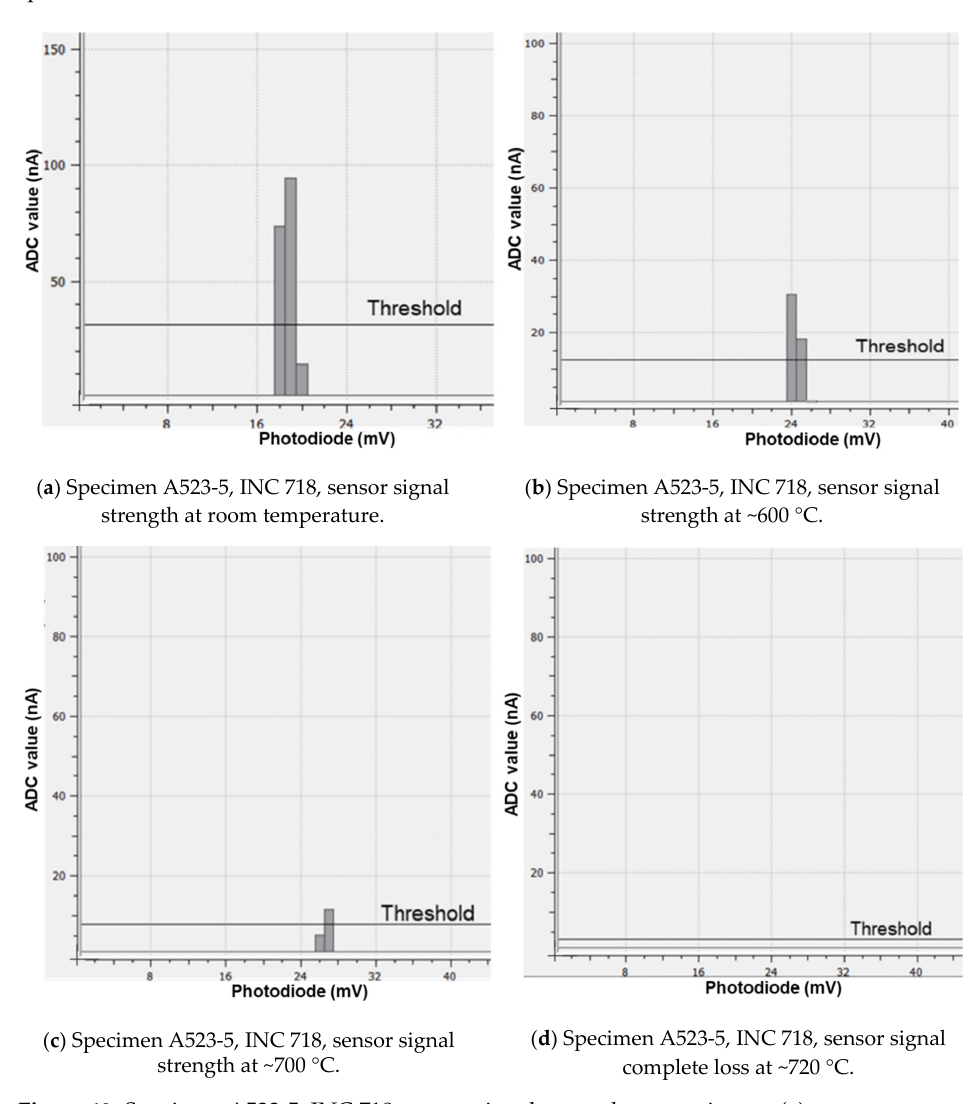
Figure 12. Specimen A523-5, INC 718, sensor signal strength comparison at ( a ) room temperature, ( b ) at ~600 °C, ( c ) at ~700 °C, and ( d ) sensor signal complete loss at ~720 °C.